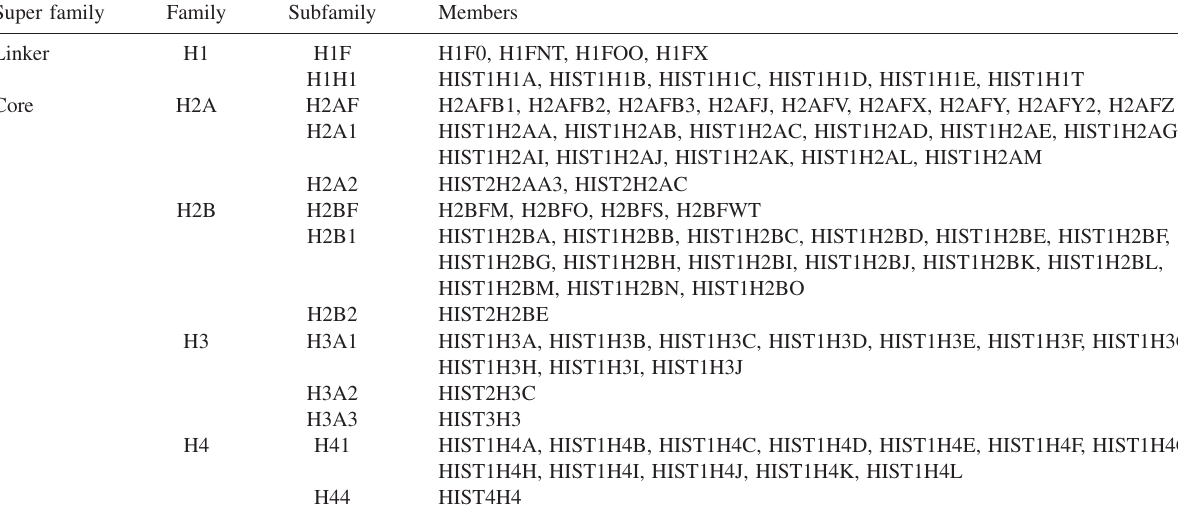
Table 7 Human histone